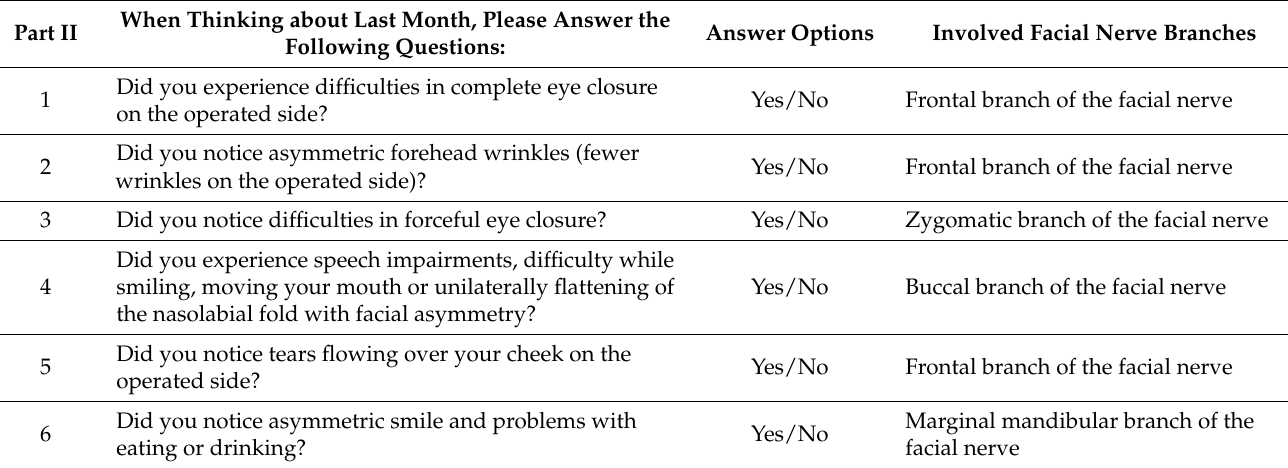
Table 2. Questionnaire Part II for facial nerve branches integrity